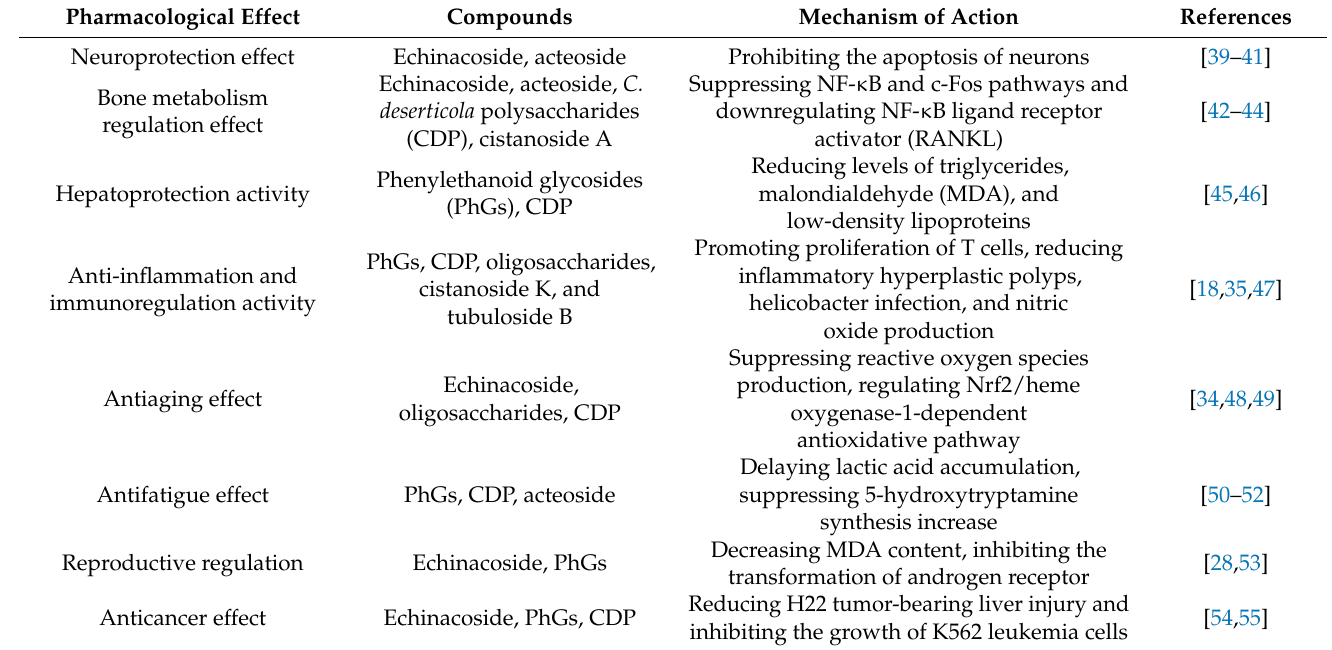
Table 1. Pharmacological effect and mechanism of action of Cistanches